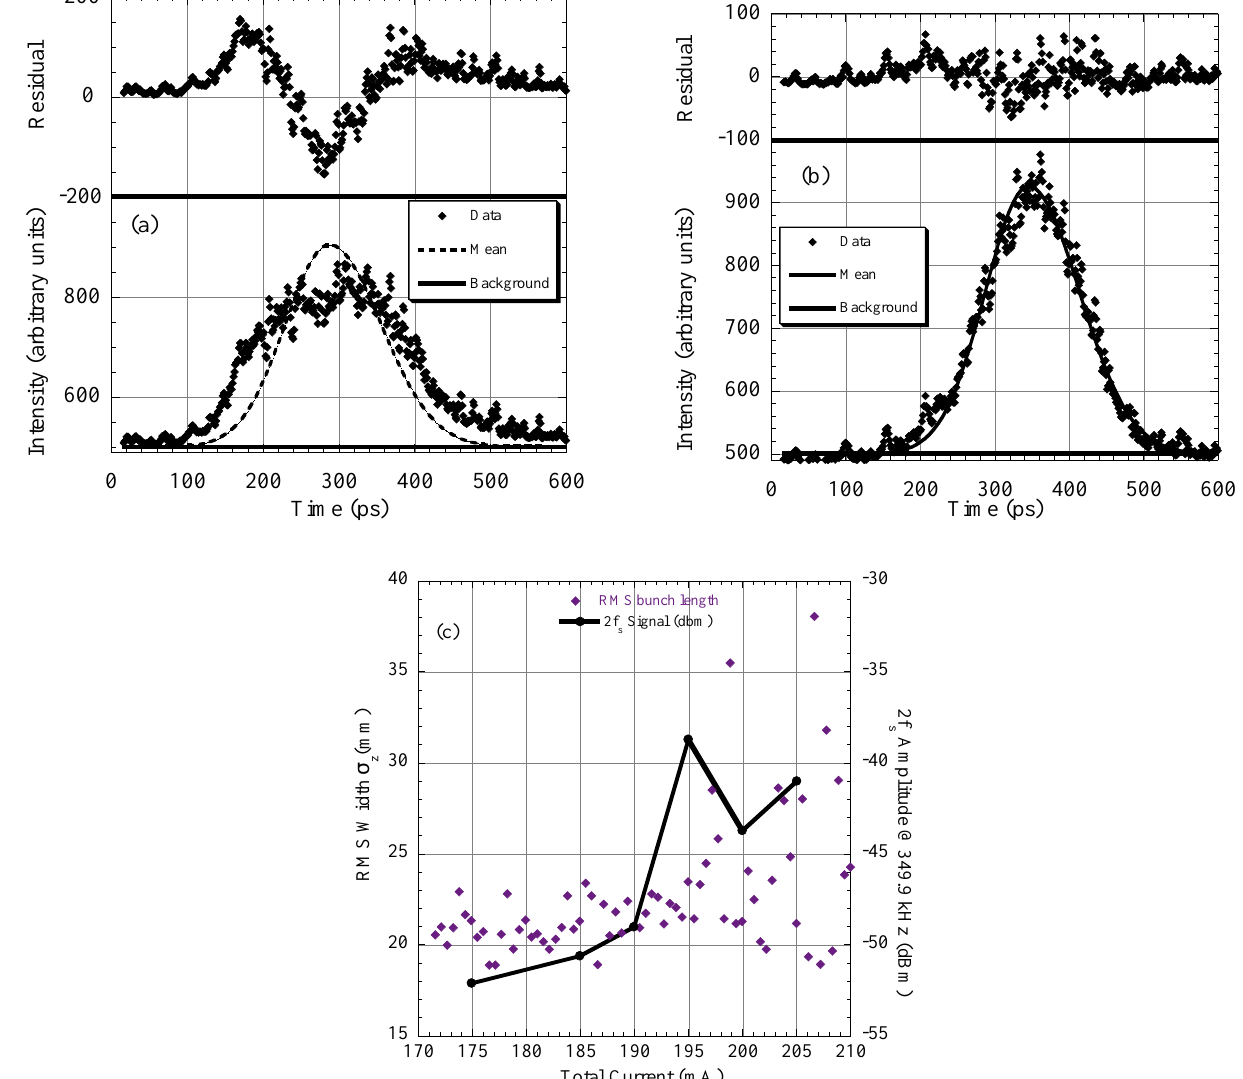
FIG. 24. (a),(b) A single data acquisition of the longitudinal bunch distribution fit to the mean stable bunch distribution when the beam is unstable. The beam spectra signals of f r 6 f s and f r 6 2 f s are present and the beam current is 200 mA during the measurement. These are two consecutive pictures of the bunch distribution and the current difference between the pictures is not more than 1 mA. The residuals are plotted above the distribution. (c) (Color) The bunch length and 2 f s spectra amplitude as a function of